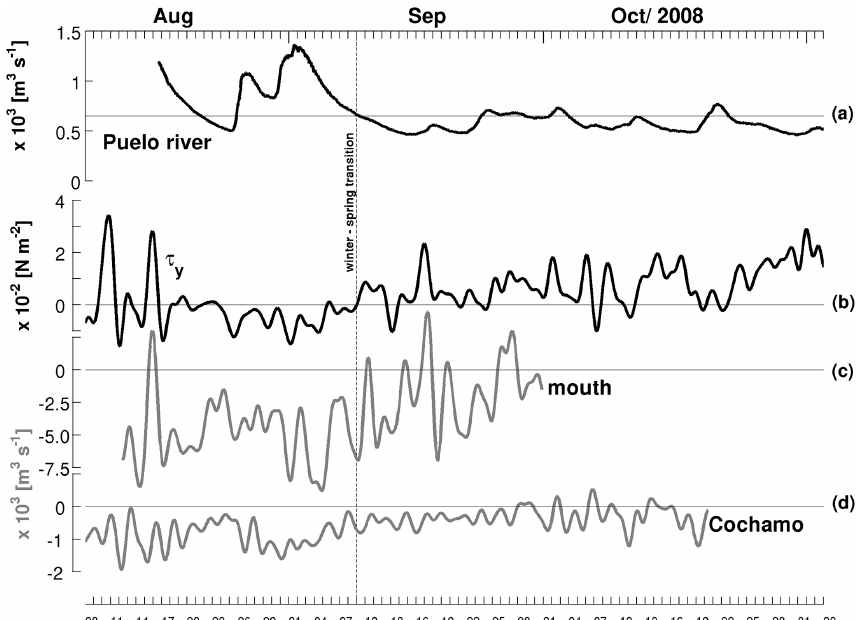
Figure 6. Low-frequency time series of the Puelo river (a) , along-fjord wind stress (b) , and the volume flux of the upper layer at the mouth (c) and at Cochamó (d) . Note the use of a different scale for the volume flux at each location. The segmented line indicates the seasonal shift in the pattern of winds between late winter and early